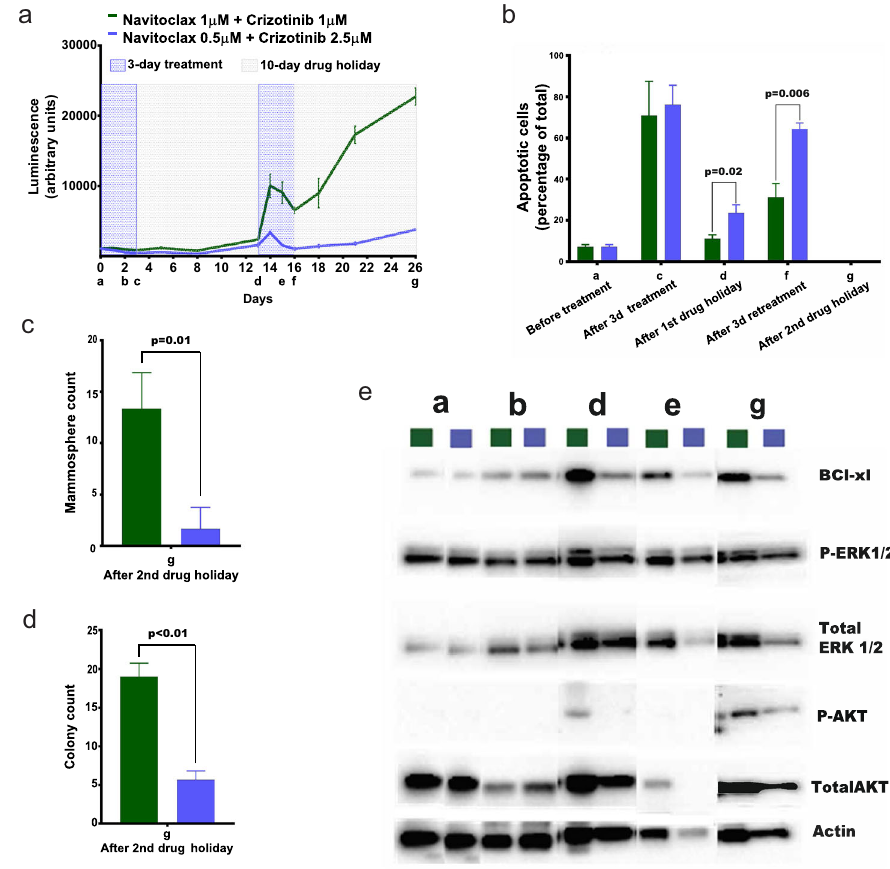
Fig. 2 Assessment of concurrent combination treatment regimens. a Cell growth curve for two different combination regimens. The schedules included two cycles, each consisting of a 3-day treatment period followed by a 10-day recovery period. Points on time axis: a-pre- treatment baseline, b-after 2 days treatment, c-after 3 days treatment, d-after 10 days of recovery, e-after 2 days of treatment in cycle 2, f-after 3 days of treatment in cycle 2, g-after 10 days of recovery in cycle 2. b Percentage of apoptotic cells using Annexin V and PI staining at different treatment points in the schedule. c Mammosphere count after the end of the treatment schedule. d Colony formation assay after the end of the treatment schedule. Representative pictures of colony formation are provided in Supplementary Fig. 2b. e Quanti fi cation by Western blot of protein levels involved in targeted pathways. In a – d , the error bars shown represent the standard deviation of triplicate measurements (biological replicates). P -values are from a two-sided t